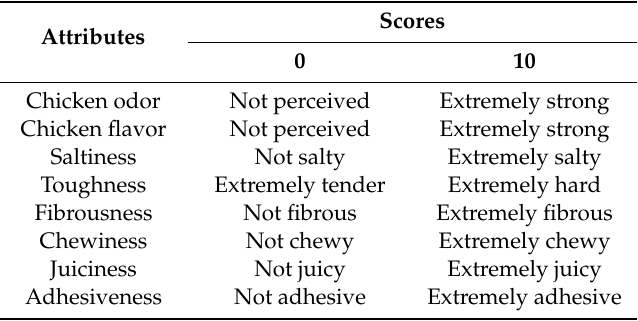
Table 1. List of the sensory attributes and